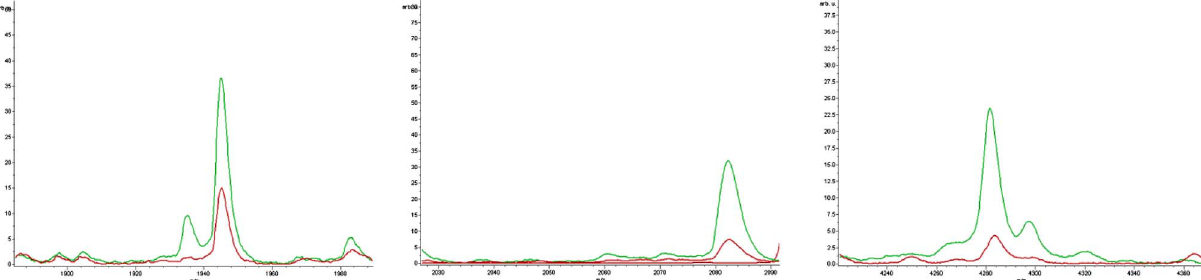
Figure 3. Peptide peaks with features of up-regulation. Compared with the healthy controls (red line), the increased peaks of the newly developed advanced schistosomiasis (NDAS) group are shown as a green line, including three peaks with m/z 1945, 2082 and